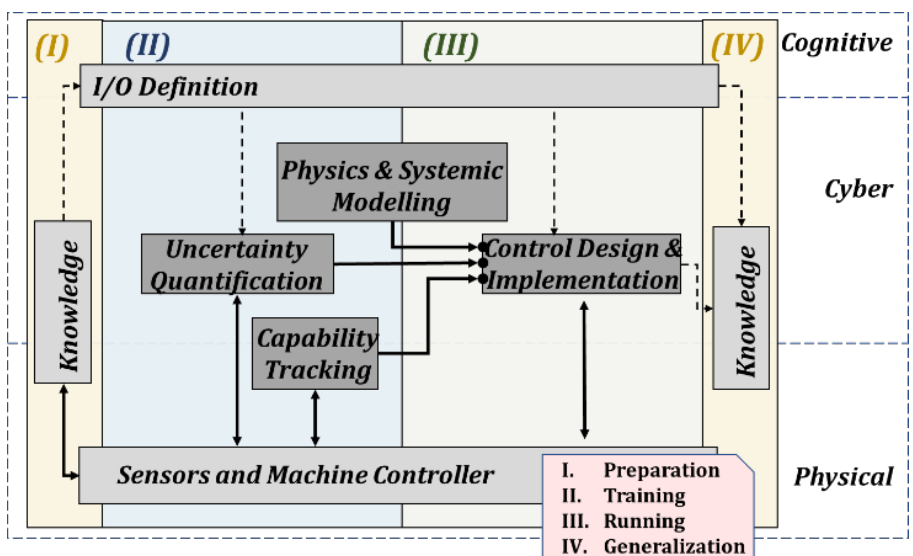
Figure 4. The current digital twin framework.